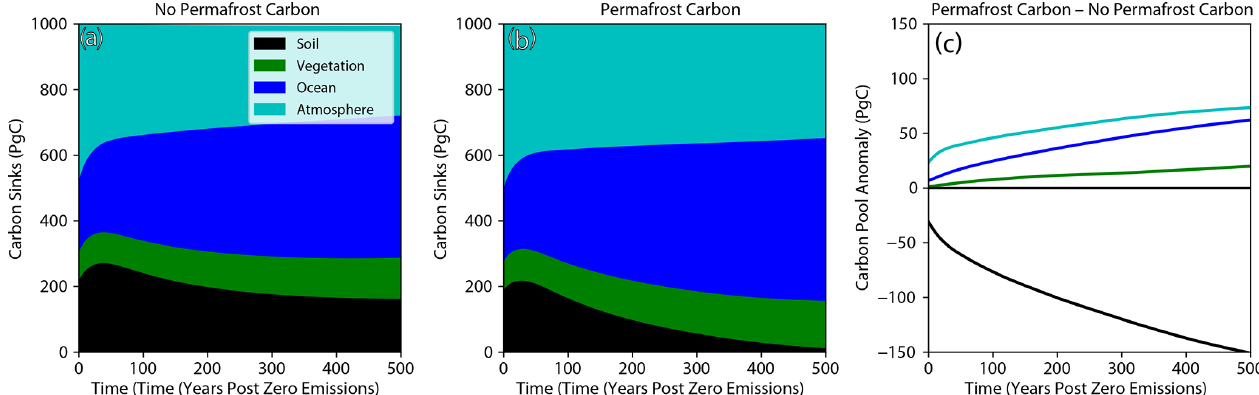
Figure 4. (a, b) Size of carbon sinks following cessation of emissions in the A1 (1000PgC) experiments with and without permafrost carbon. (c) Difference in size of carbon pools between the simulation with and the simulation without permafrost carbon. The total of all carbon sinks remains 1000PgC after emissions